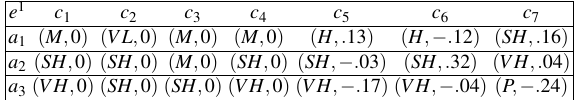
Table 5. Unified information provided by e 1 .